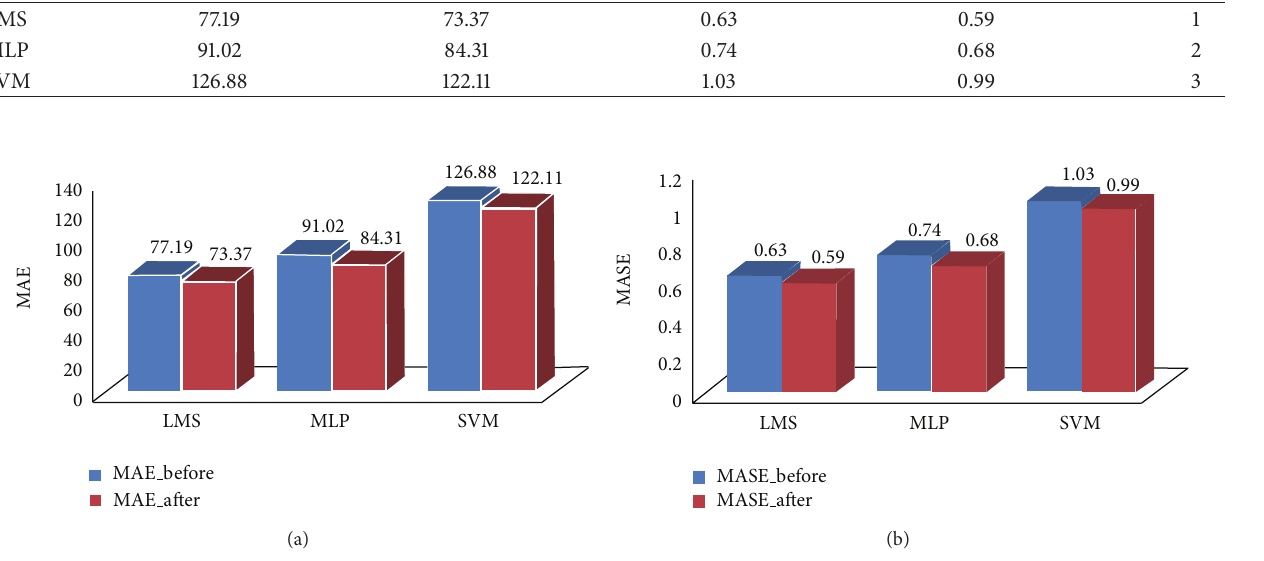
Figure 3: MAE (a) and MASE (b) comparison of LMS, MLP, and SVM before and after feature selection process.